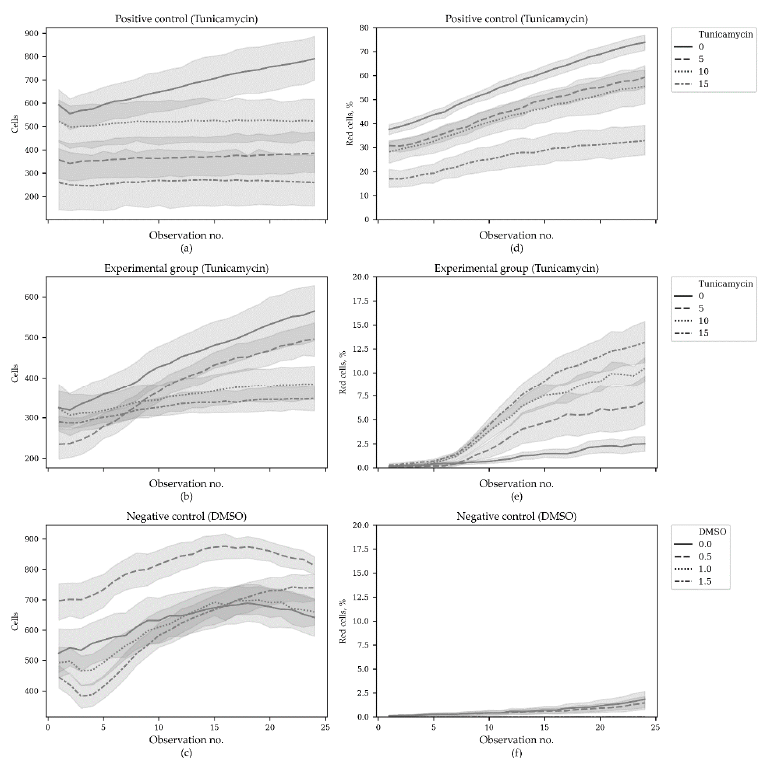
Figure 4. Cell counts and percentage of the red cells during the second ER stress time course experiment. In total, 5208 microscopic images were analyzed. Positive control—a group of cells that constantly expressed TagRFP; experimental group—the cells with TagRFP expression induced under ER stress conditions. These two groups were treated with different tunicamycin concentrations (µg/ml). Negative control group—the ER-responsive cells treated with different DMSO concentrations (%). Panels ( a ), ( b ) and ( c ) show the cell counts throughout the time course and panels ( d ), ( e ) and ( f )—the red cells percentage. N = 18. The horizontal axes correspond to observation